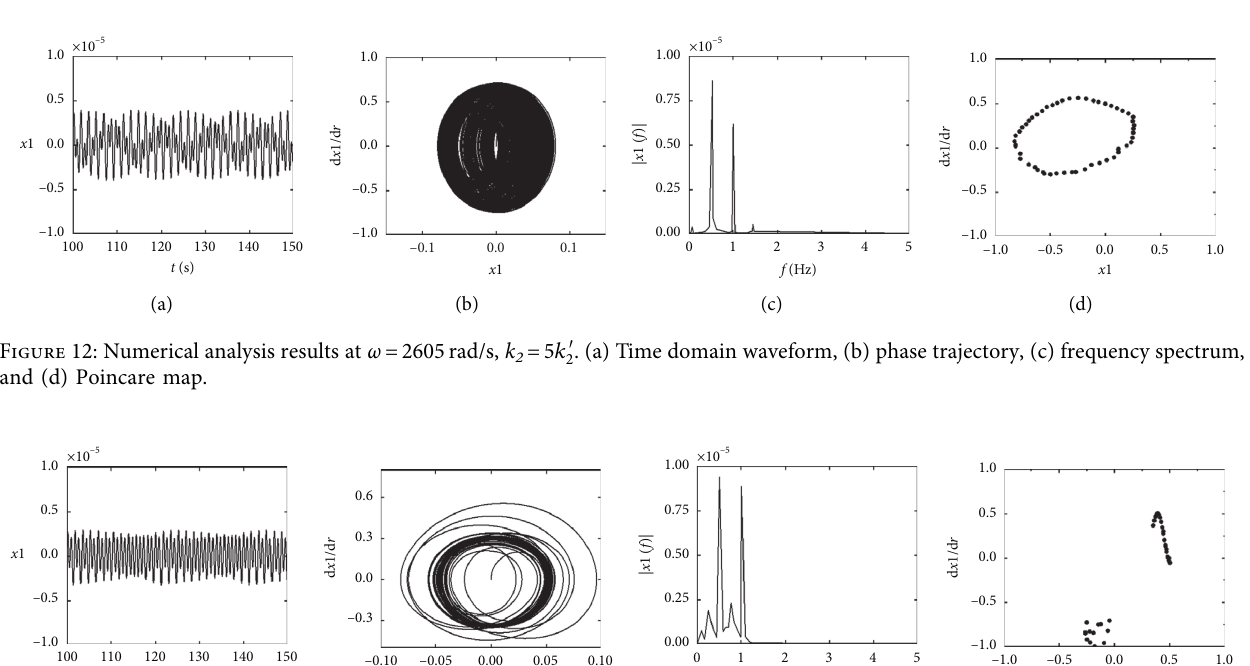
Figure 11: Numerical analysis results at ω � 2000rad/s, k and (d) Poincare map.